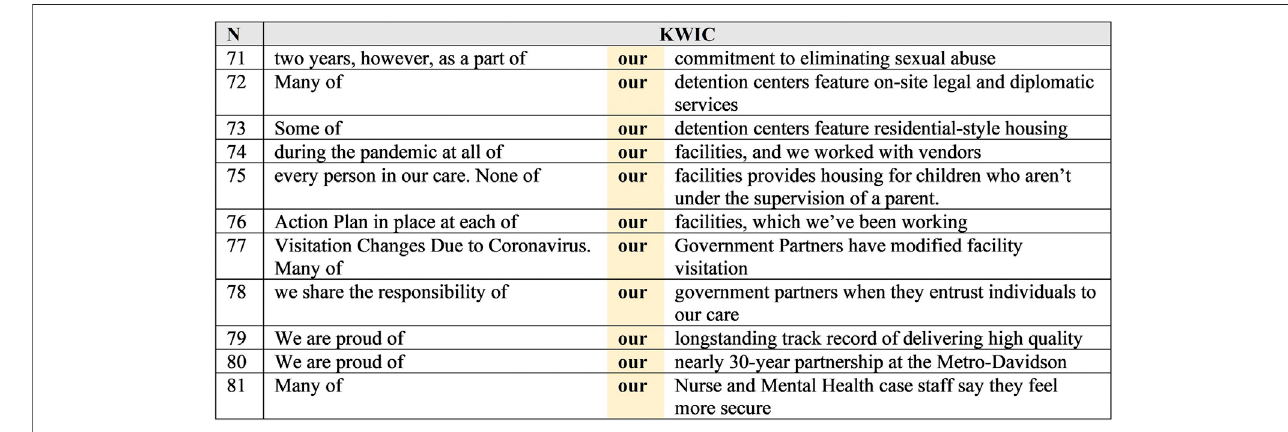
FIGURE 2 | CoreCivic corpus, “ our ” concordance lines 71 – 81.